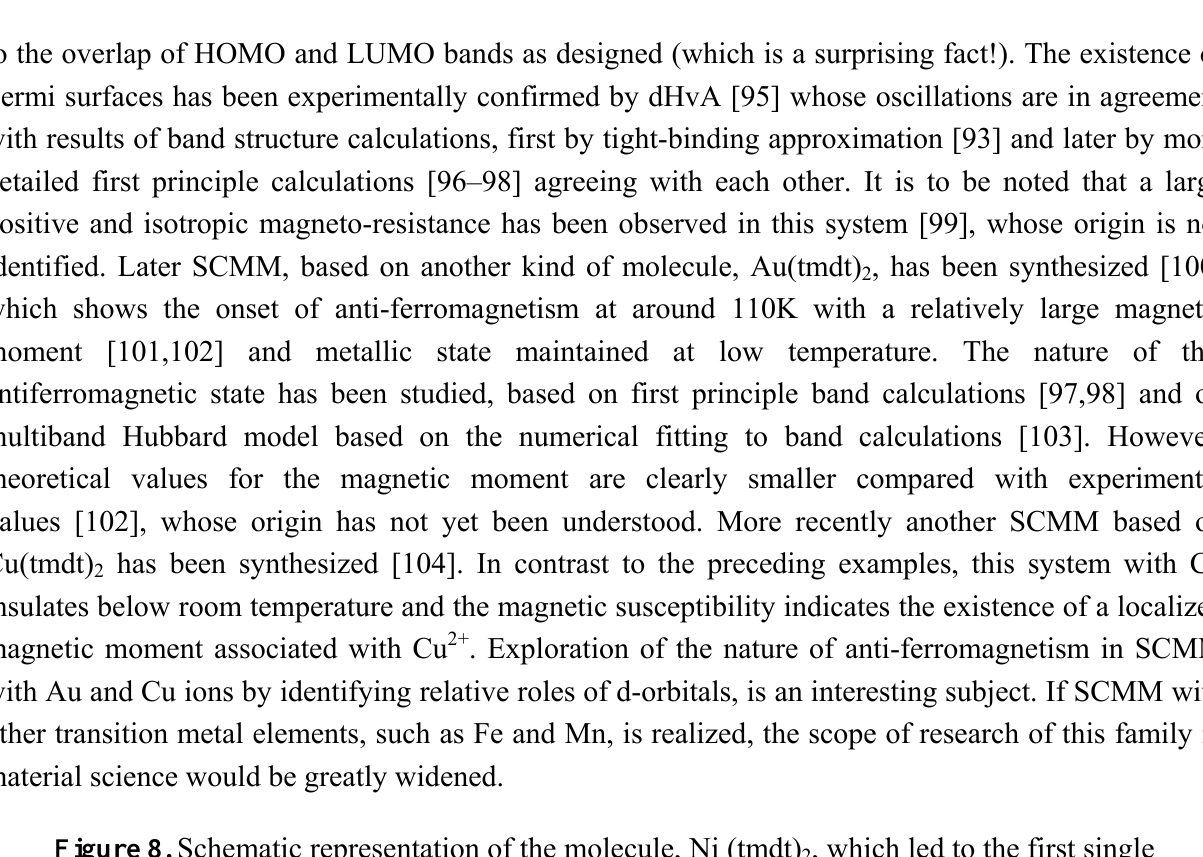
, which led to the first single 2